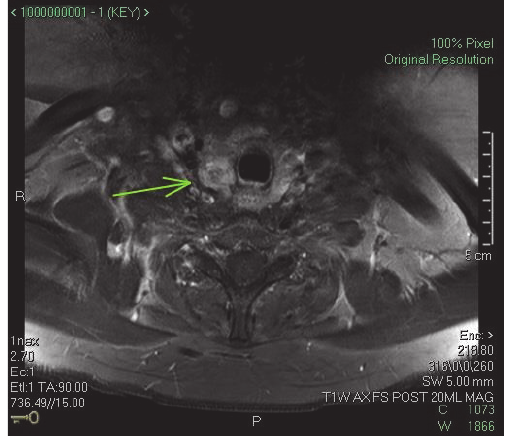
Figure 2: Axial section from the preoperative magnetic resonance images showing the same mass.